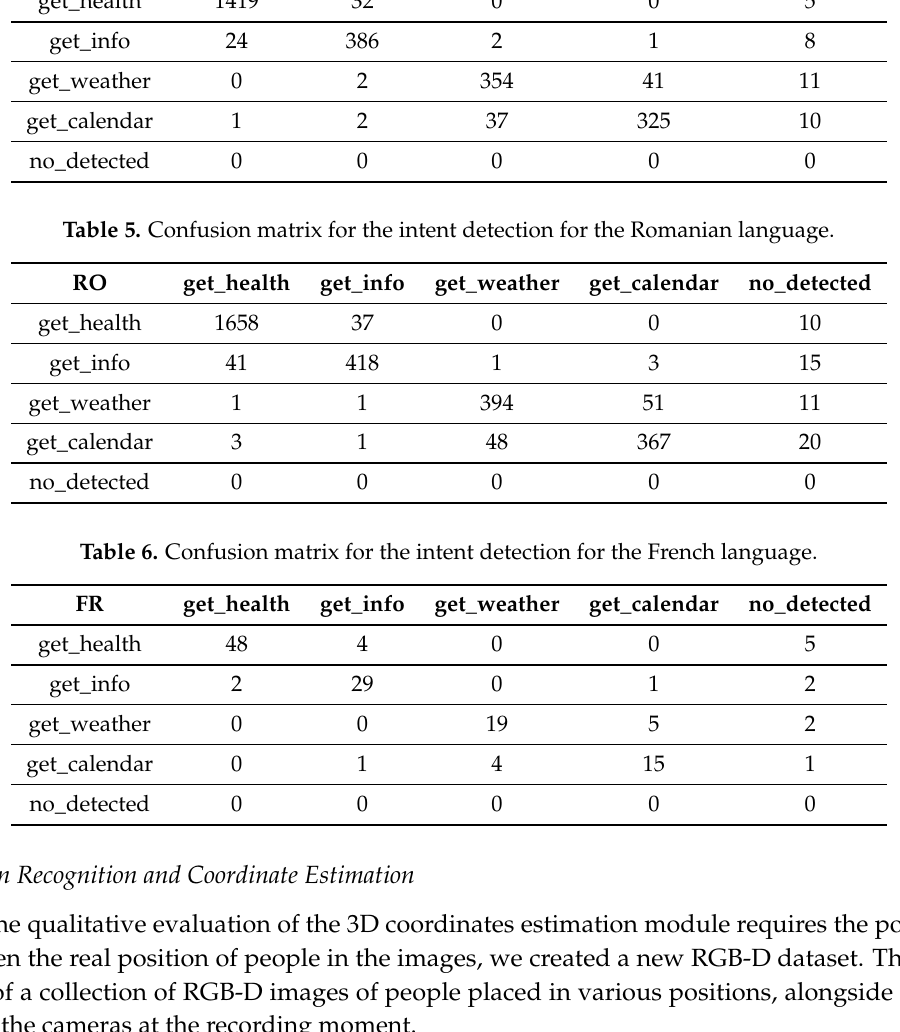
Figure 9 is a visual exemplification of the 5 postures of the